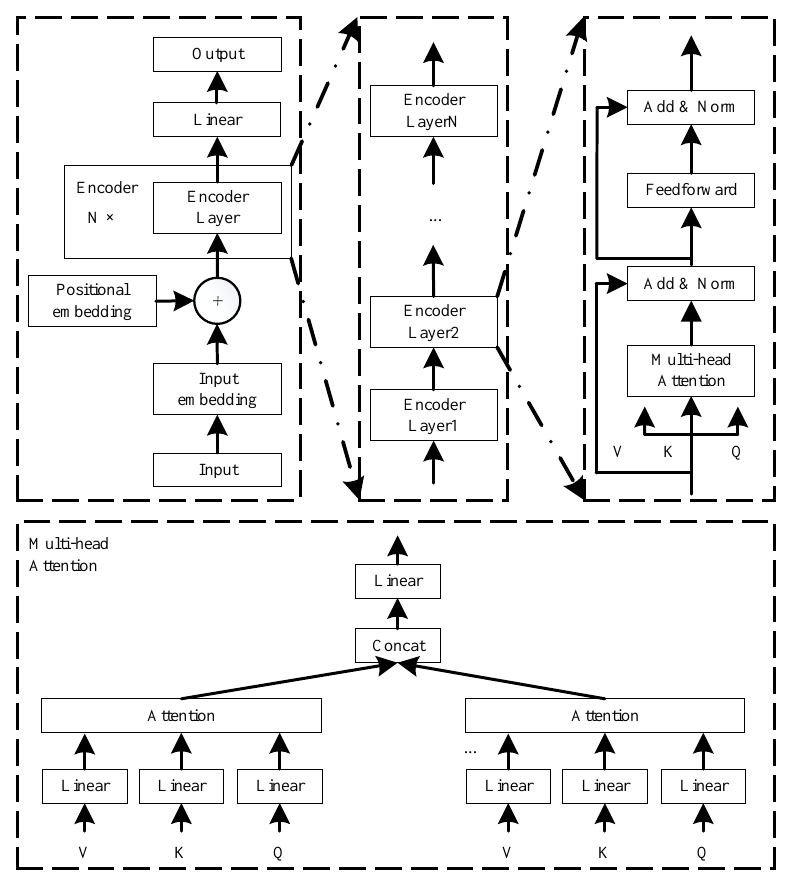
model. Figure 2. The flow chart of the proposed transformer :::::